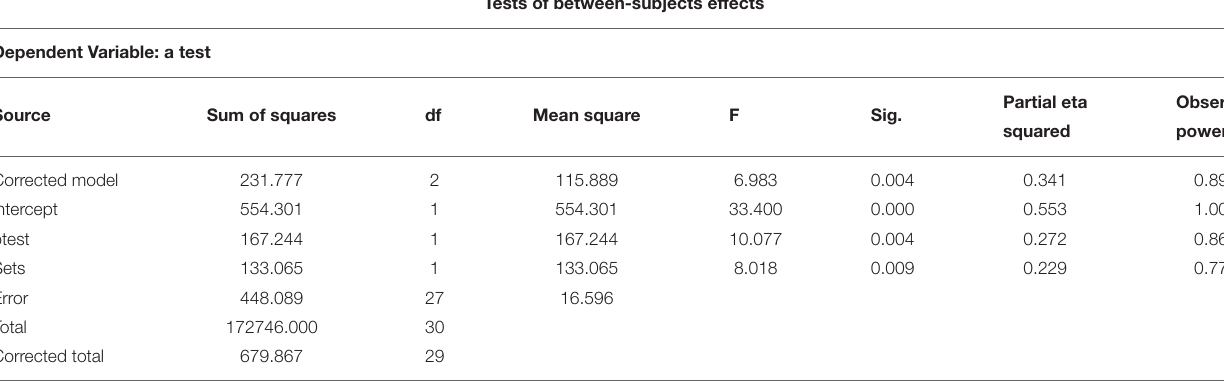
Tests of between-subjects